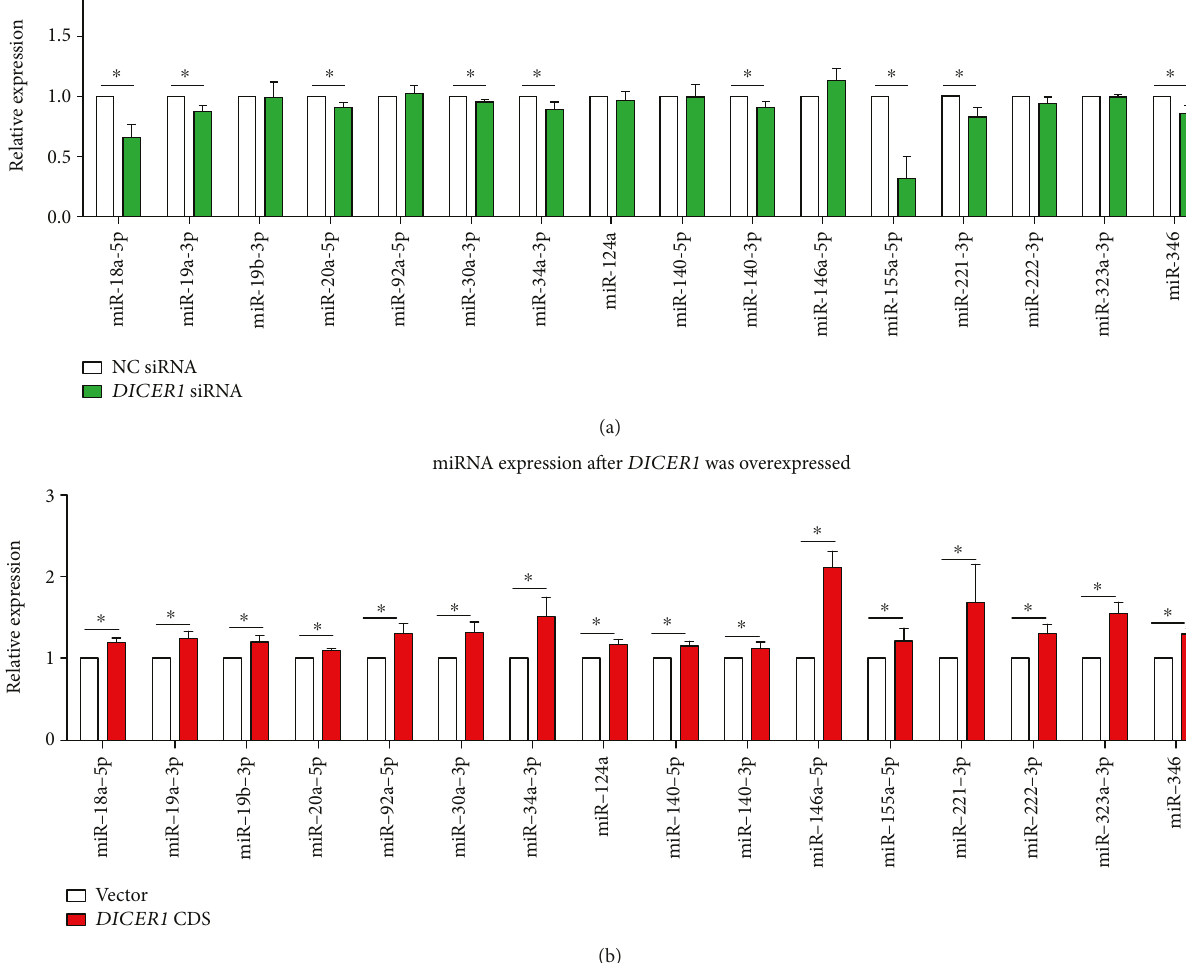
Figure 4: Altered expression of arthritis-related miRNAs caused by gain or loss of DICER1 function for 48 h in SW982 human synoviocytes. (a, b) RT-qPCR result of 15 RA-related miRNAs in the DICER1 knockdown (a) or overexpression (b) groups. Bar: mean ± SEM from three independent cell experiments, and triplicates were used for each cell transfection experiment. ∗ P < 0 05 using the Mann-Whitney